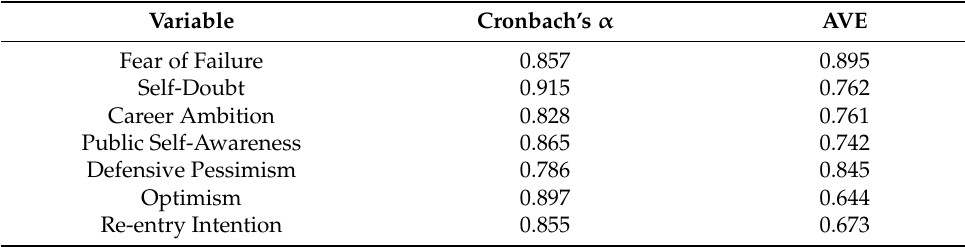
Table 3. Reliability analysis.